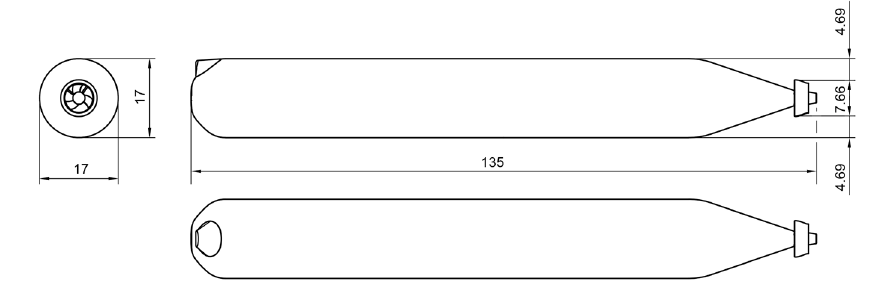
Figure 3. Subsea shuttle tanker’s overall dimensions in meters. Table 1. Main design parameters [14].